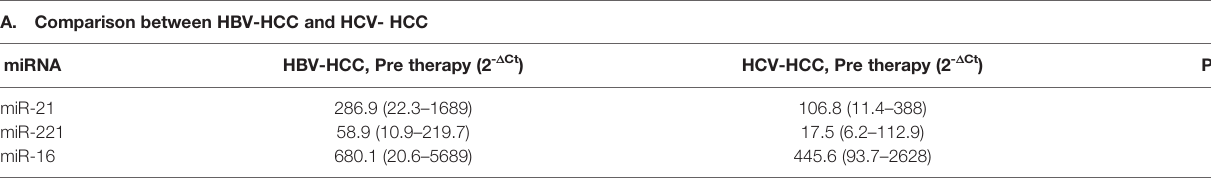
TABLE 3A | Comparison of oncomiRs expression in HBV-HCC and HCV-HCC before LRT. A. Comparison between HBV-HCC and HCV- HCC miRNA